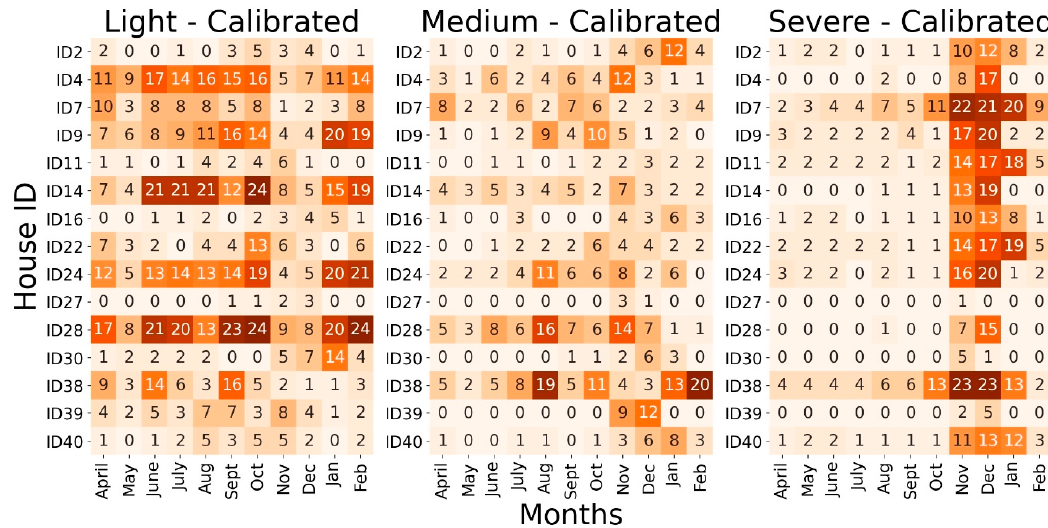
Figure A6. Results of the underheating criteria 2 applied to the calibrated models. The X axis shows the months, and Y axis shows the house ID. The intersection of both shows the number of underheated light (left), medium (middle), and severe (right) days in that month.